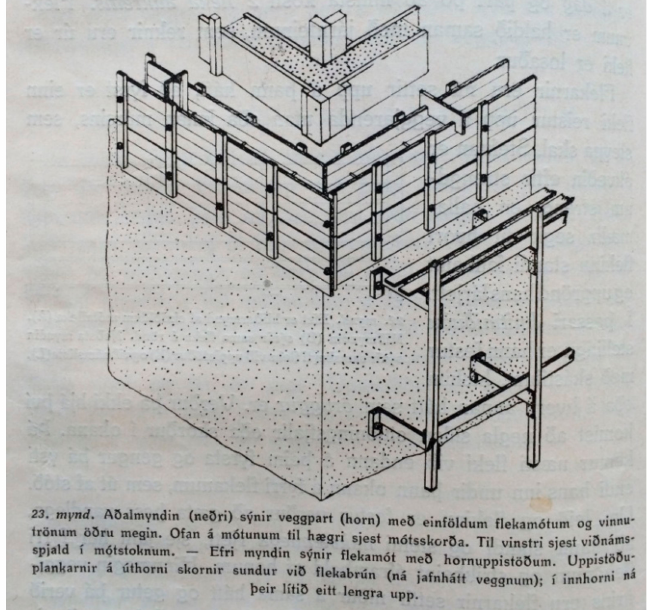
Figure 8. Guðmundur Hannesson, Steinsteypa: Leiðarv í sir fyrir alþ ý ðu og viðvaninga , 1921. Details of the formworks. Copy available at the Reykjav í k City